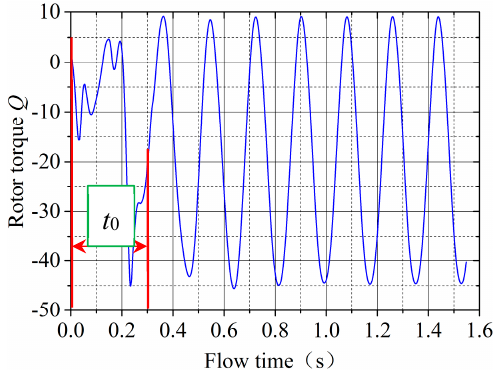
Figure 10. Monitor of torque of rotor for CFD simulations.